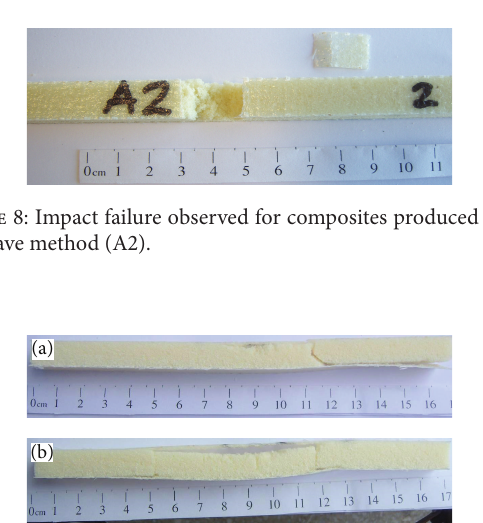
Figure 9: Samples of pressed composites P2 (a) and P3 (b) damaged during impact strength